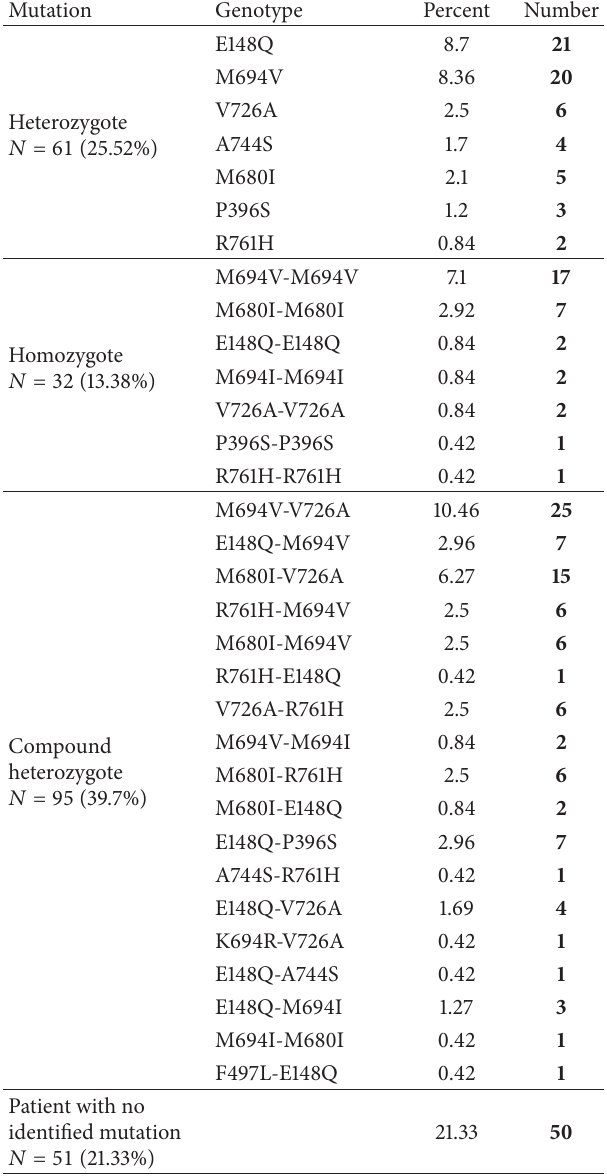
Table 3: Genotype and phenotype correlations. Common The most combined common mutations